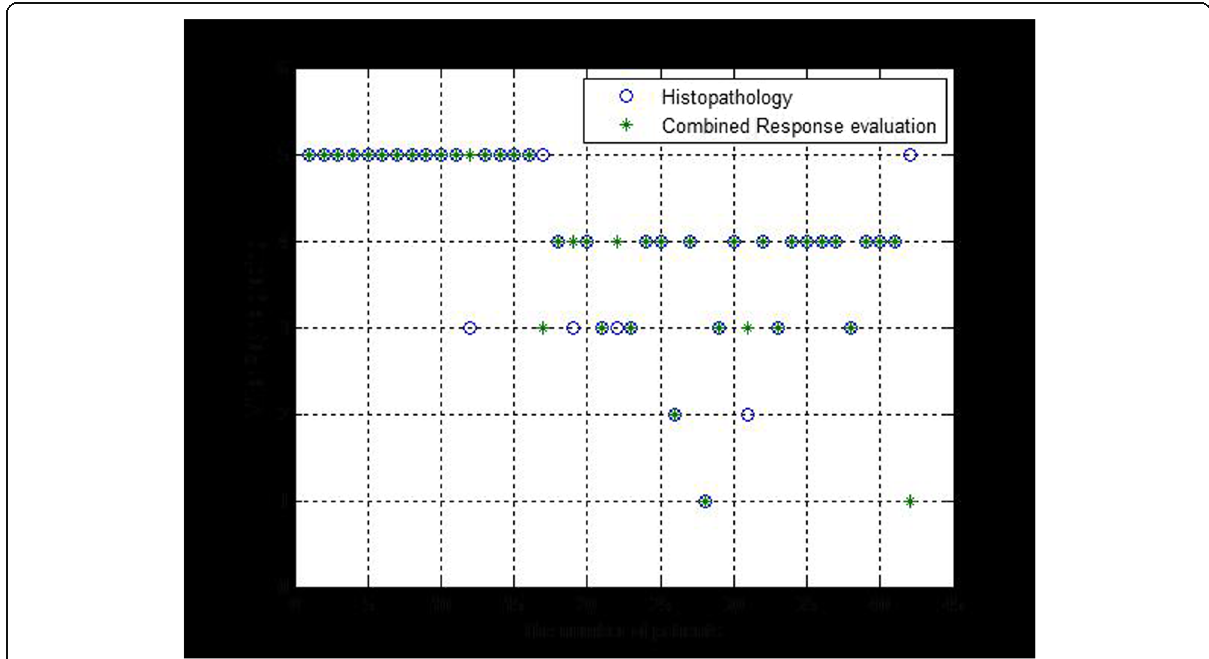
Fig. 2 The correlation between the combined response evaluation and the corresponding Miller – Payne